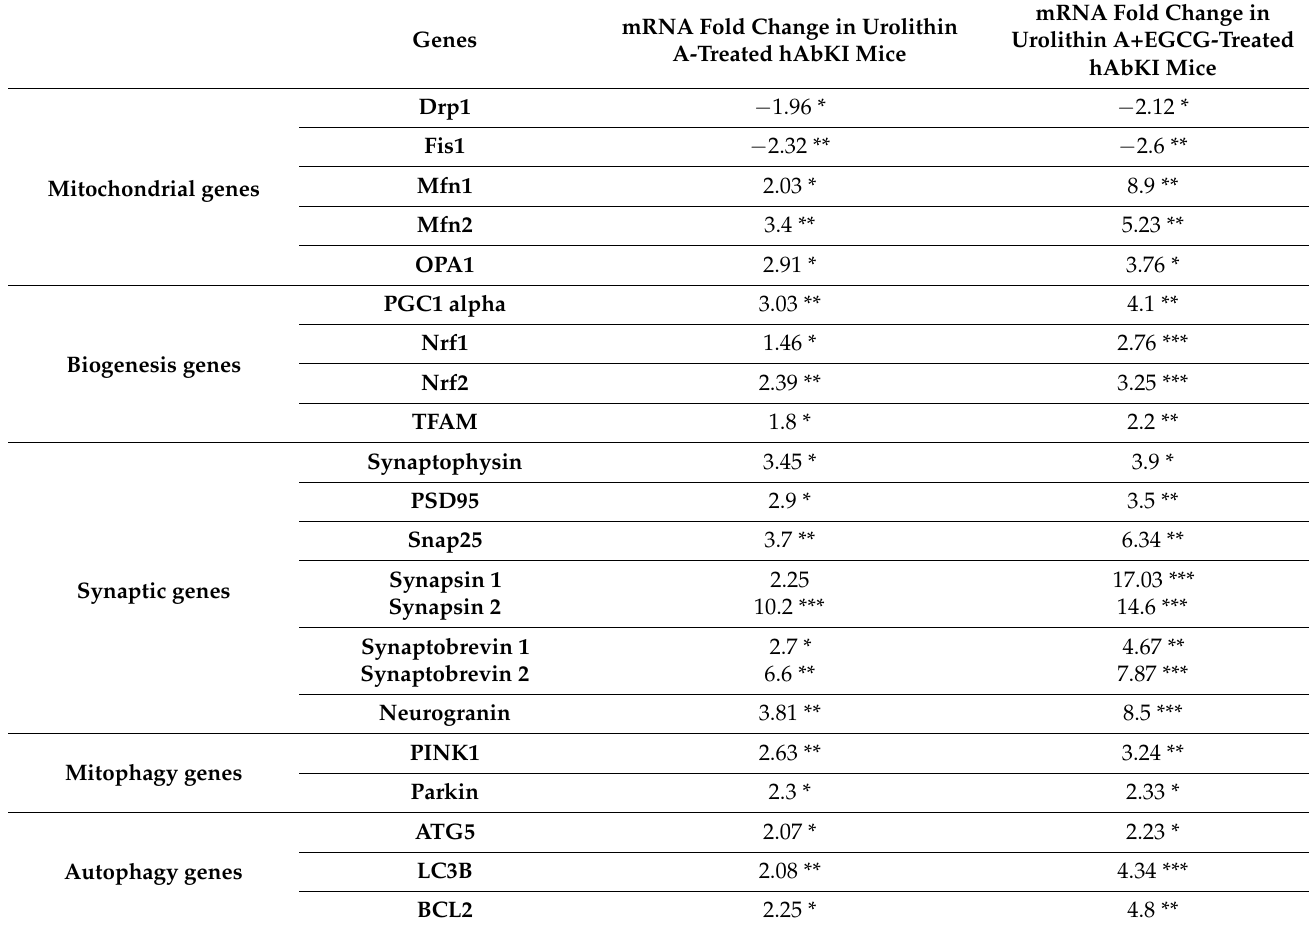
Table 4. Summary of mRNA fold changes comparison in Urolithin A-treated hAbKI mice and Urolithin A+EGCG treated hAbKI mice. mRNA Fold Change in Urolithin Genes A-Treated hAbKI Mice